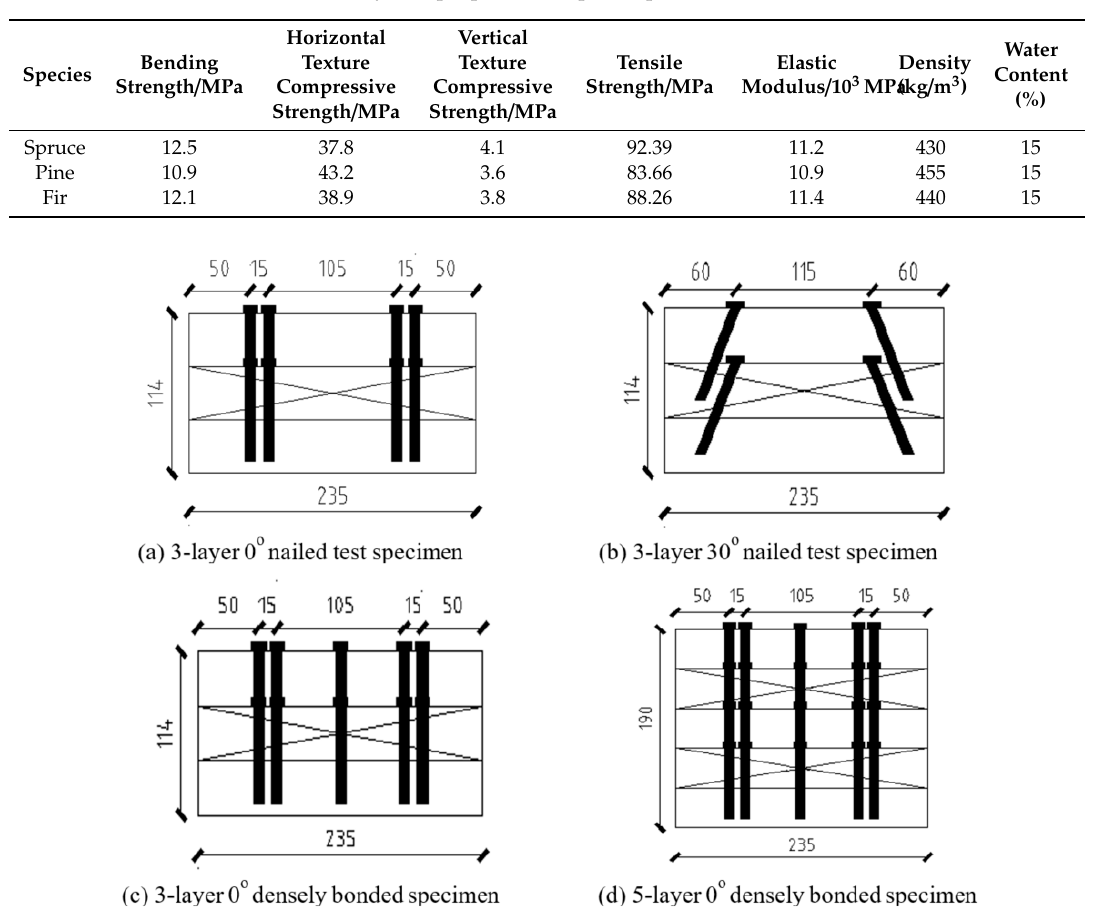
Figure 1. Partial detail view of specimens.